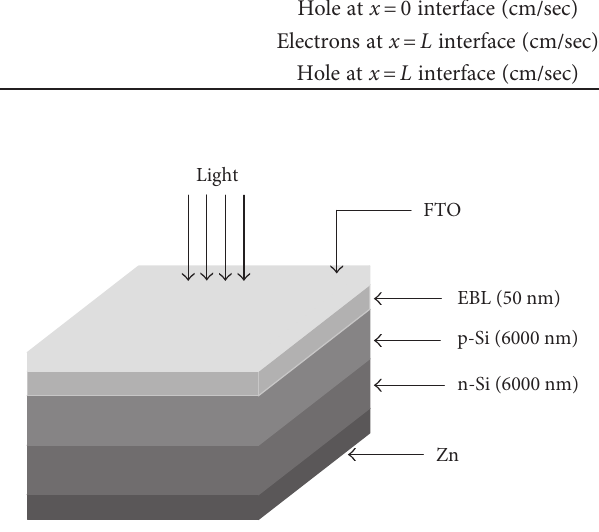
Figure 1: The proposed schematic diagram of p-n homojunction solar cell with